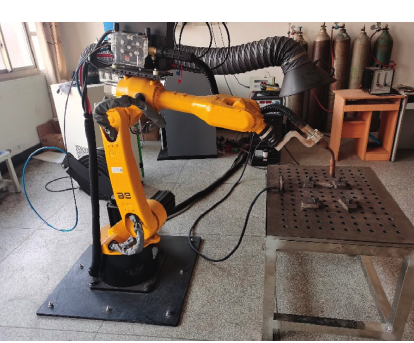
Figure 1: WAAM experimental system used in this work. Table 2: WAAM parameters used in this work.